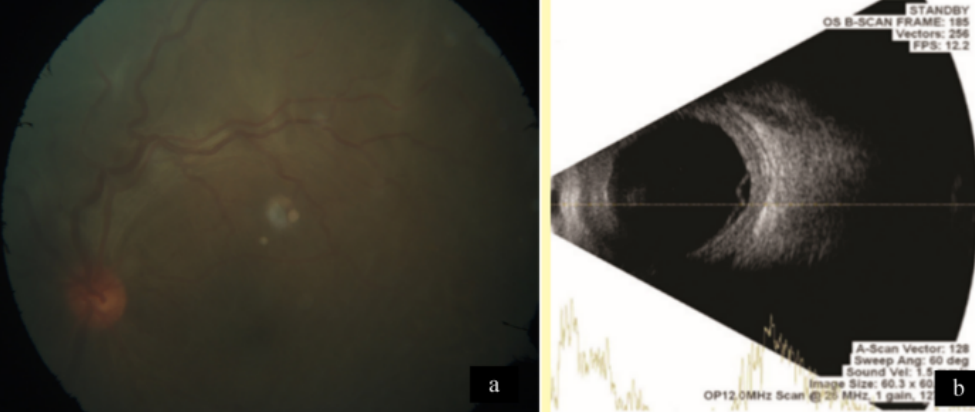
Figure 2: a) Fundus of the left eye showing exudative retinal detachment. b) B-scan ultrasonography showing exudative retinal detachment with thickened choroid and fluid in sub-Tenon’s